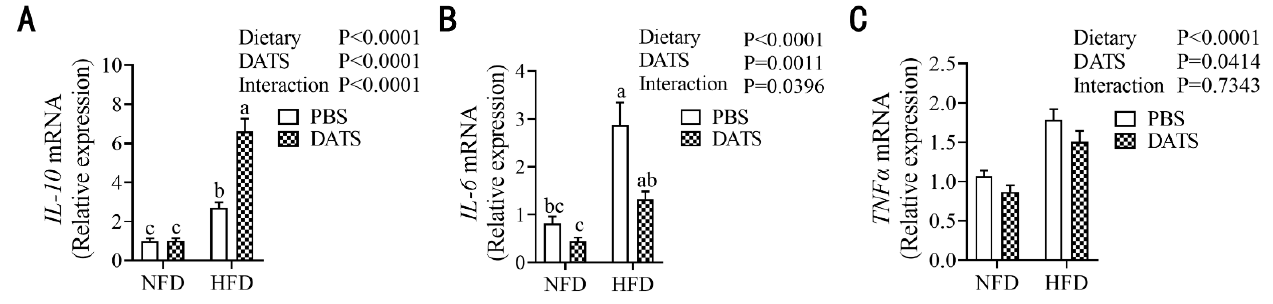
Figure 5. DATS treatment can alleviate the level of placental inflammation in obese mice during pregnancy. ( A – C ) Relative IL-10, IL-6 and TNF α mRNA expression ( n = 9–11 mice/group). Two-way ANOVA—the values represent the mean ± SEM, p < 0.05 was considered to indicate statistical significance and different letters indicate significant differences.